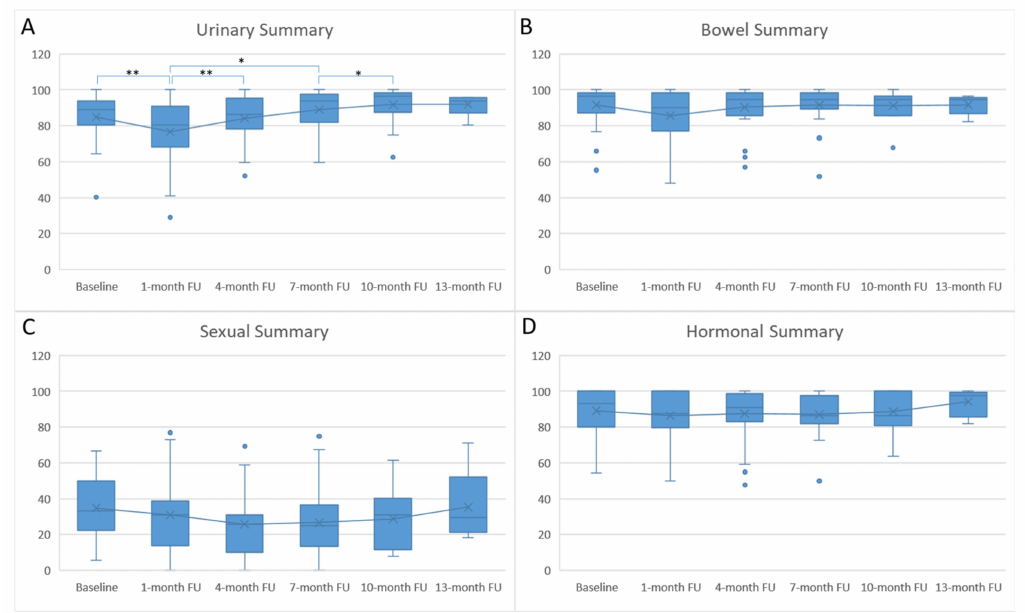
Figure 2. Boxplots of the Expanded Prostate Cancer Index Composite Questionnaire results. ( A ) Urinary, ( B ) bowel, ( C ) sexual, and ( D ) hormonal domain summary scores with regard to follow-up (FU) time. The cross point ( × ) indicates mean value. The line inside each bar indicates median value. Statistically significant differences between each two time points (Mann–Whitney U test) are indicated by * ( p < 0.05) and ** ( p <